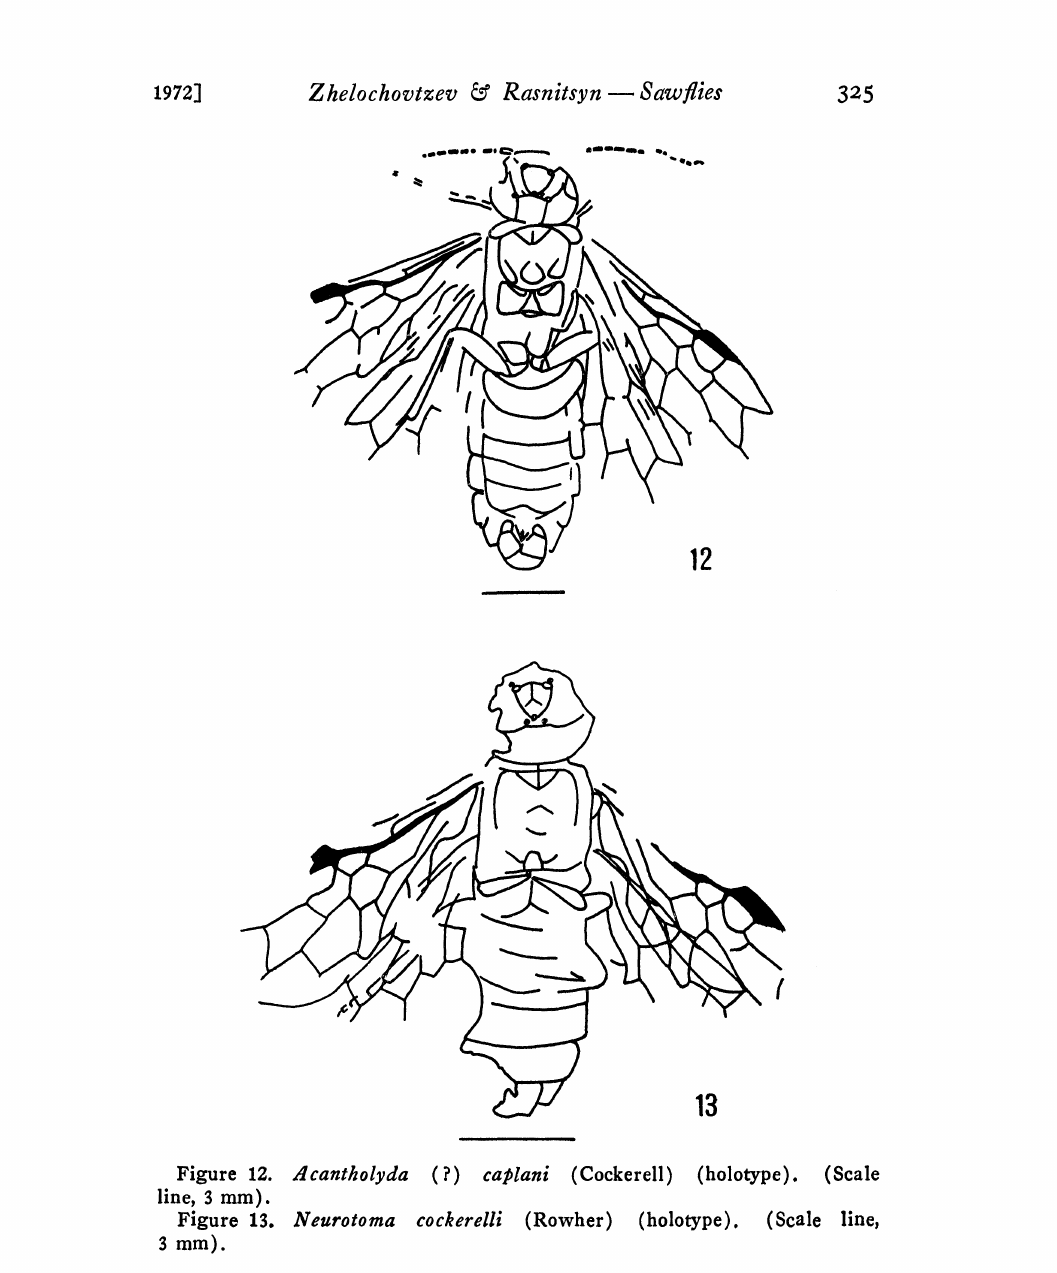
Figure 12. /lcantholyda (?) caplani (Cockerell) (holotype). (Scale line, 3 ram). Figure 13. lgeurotoma cockerelli (Rowher) (holotype). (Scale line, 3